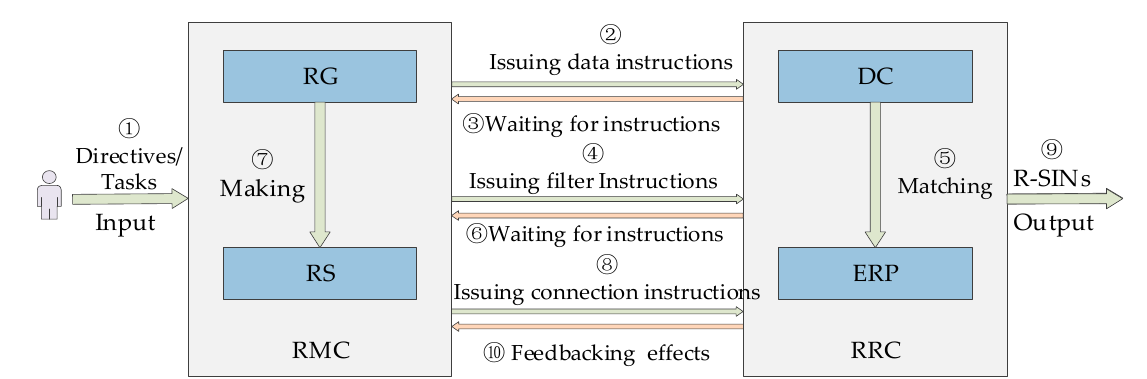
Figure 5. The operation mechanism of each module of the R-SIN.